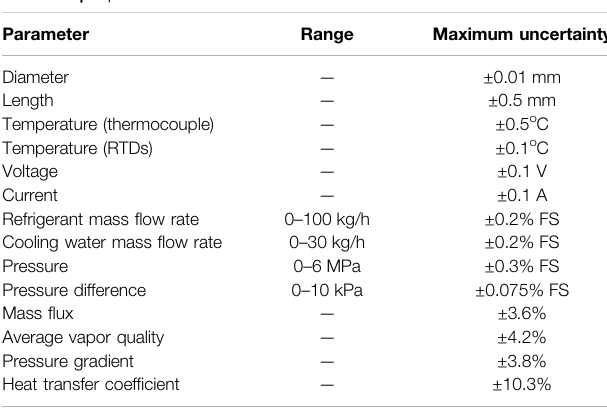
TABLE 3 | Experimental uncertainties.